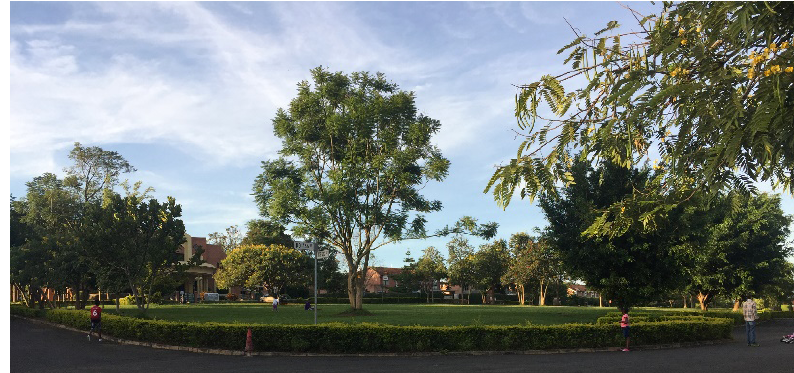
Figure 28. The Kigali 2020 Central Park. Photograph by Manlio Michieletto.